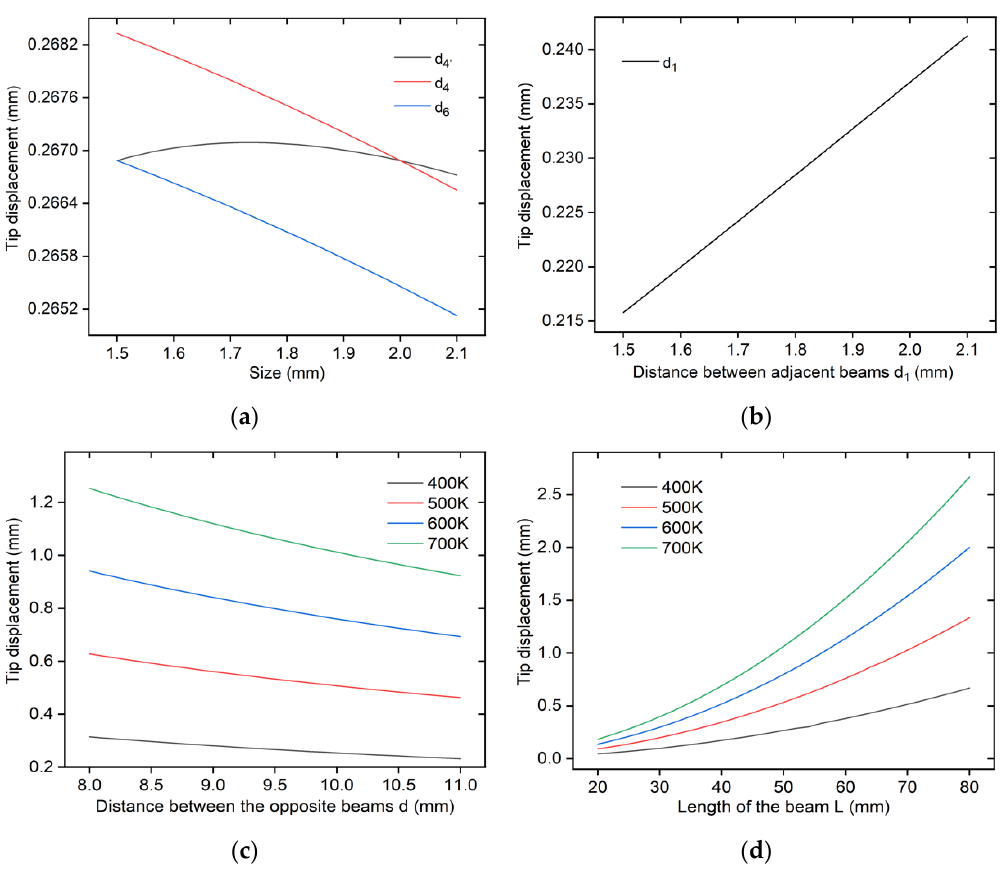
Figure 11. Parameter analyses of the 3D U-shaped actuator. ( a ) Output displacements vs. d 4 , d 6 , and d 4 ; ( b ) Output displacement vs. d 1 ; ( c ) Output displacement vs. d ; ( d ) Output displacement vs. length of the beam L